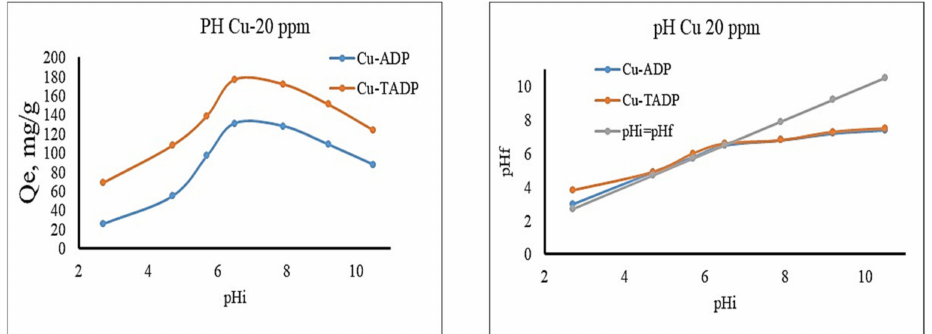
Figure 6. Adsorption capacity (qe) as a function of initial pH (pHi) and pHi versus pHf (final pH) plot for Cu(II) adsorption onto ADP and TADP. (Optimal conditions: initial concentration 25 mg/L; adsorbent weight 0.005 g; volume 0.05 L; temperature 25 ◦ C; contact time 5 h; shaker speed 100